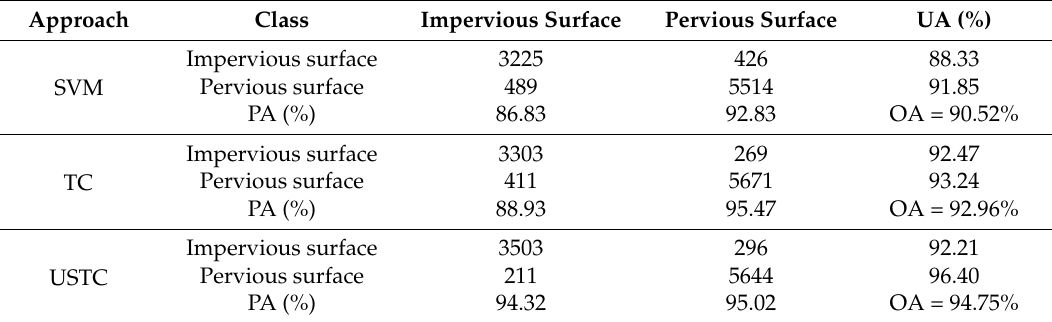
Figure 6. Comparison of three classification results in the main urban area of Xinzhou district, showing the data gap case. Table 2. The confusion matrix in all of the years of the study period: UA is user’s accuracy; PA is producer’s accuracy, and OA is overall accuracy.